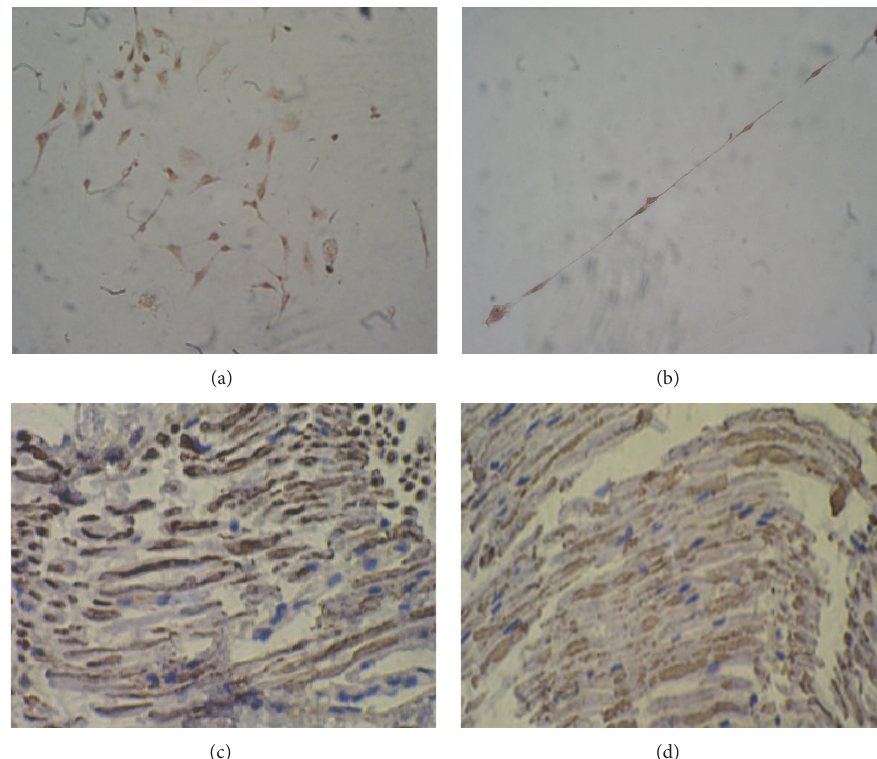
Figure 1: (a) Immunocytochemical staining of GFAP in Schwann cells-like cells that differentiated from ADSCs. (b) Immunocytochemical staining of S-100 in Schwann cells-like cells that differentiated from ADSCs. (c) BrdU and S-100 staining of longitudinal nerve slices from group B at 6w, blue BrdU-labeled Schwann cells-like cells’ nucleus, and brown S100-labeled staining myelin sheath were observed under microscope. (d) BrdU and S-100 staining of longitudinal nerve slices from group B at 12w, blue BrdU-labeled Schwann cells-like cells’ nucleus, and brown S100-labeled staining myelin sheath were observed under microscope.